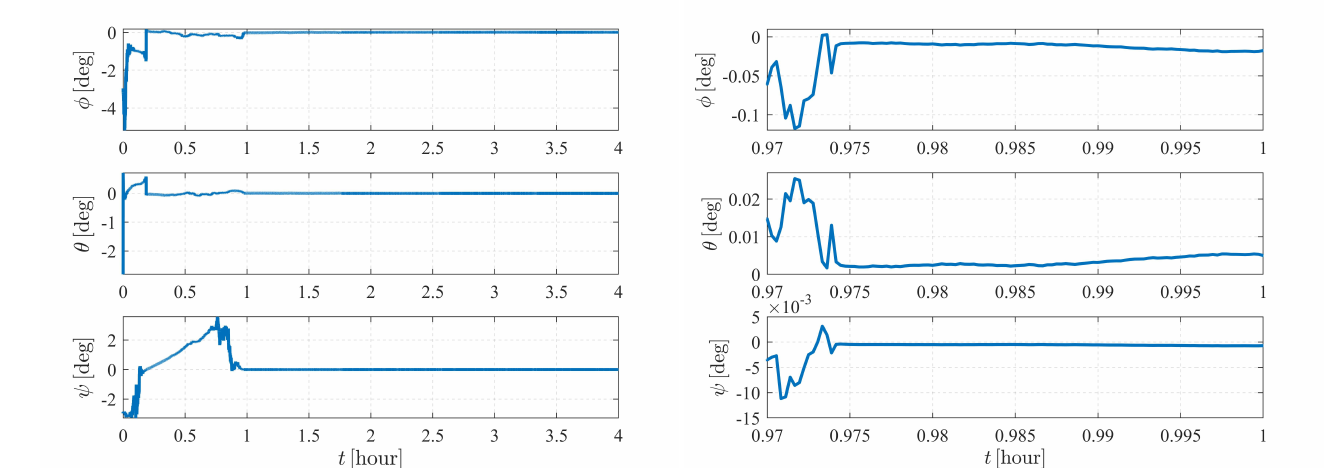
Figure 19. Attitude determination errors of case V (nonperturbation) and the corresponding larger plot.